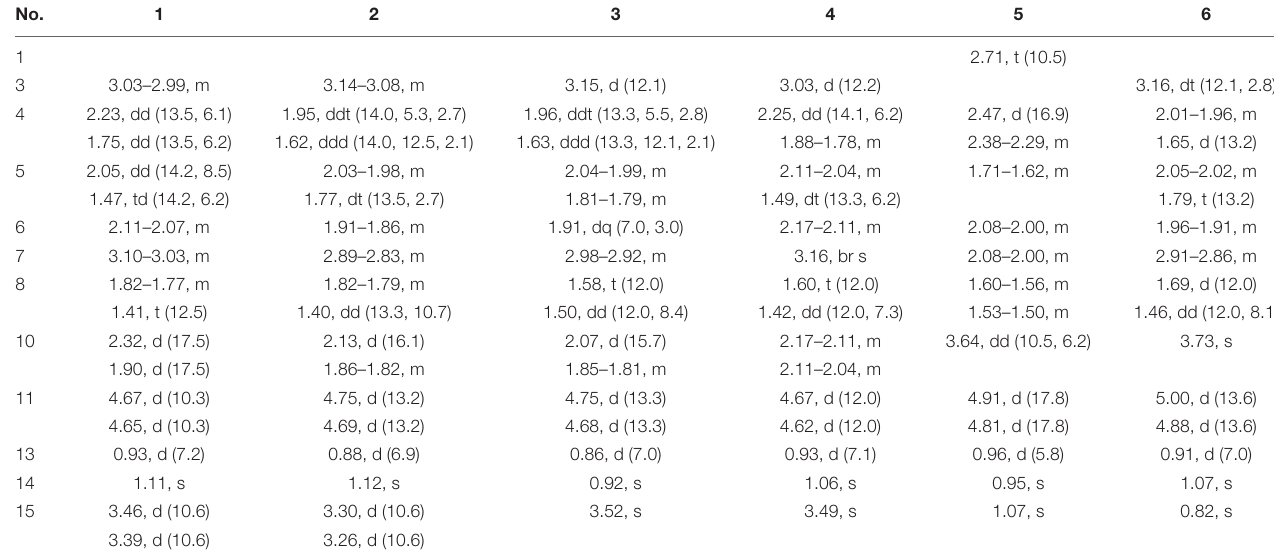
TABLE 1 | 1 H NMR data of compounds 1 – 6 in CDCl 3 at 600 MHz.